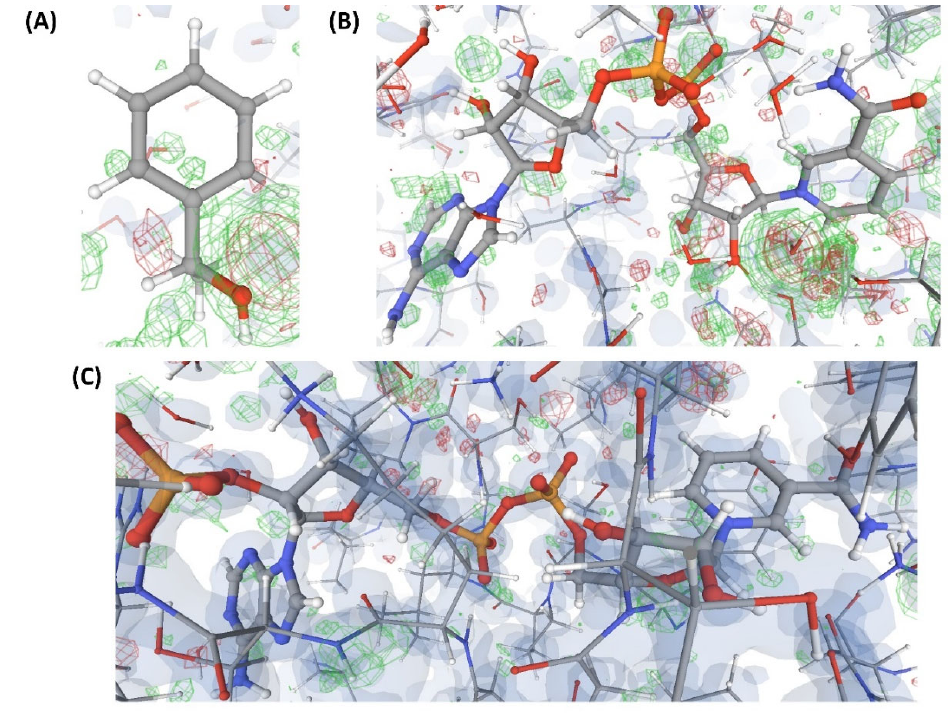
Figure 7. Electron density maps around the ligands (substrate and co ‐ substrate) bound to the structures (C7 and C8) discussed in case study ‐ 2. ( A ) L’” in C7 (1.54 Å). ( B ) L7 in C7 (1.54 Å). ( C ) L” in C8 (1.78 Å). ( D ) L5 in C8 (1.78 Å). For details on graphical representation styles and color codes of density maps, kindly refer to the legend of Figure 4.